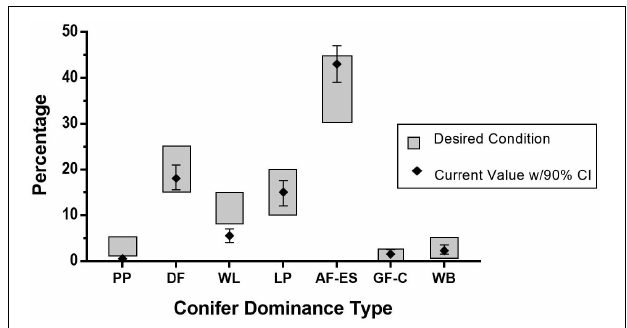
FIGURE 1 | Comparison of existing condition to desired conditions (rectangles) for ponderosa pine (PP), western larch (WL), and spruce-subalpine fir (AF-ES) Dominance Type Groups for the Flathead National Forest. Existing condition (diamond) and the 90% confidence interval (whiskers) of estimates of Dominance Types using Forest Inventory and Analysis (FIA) inventory